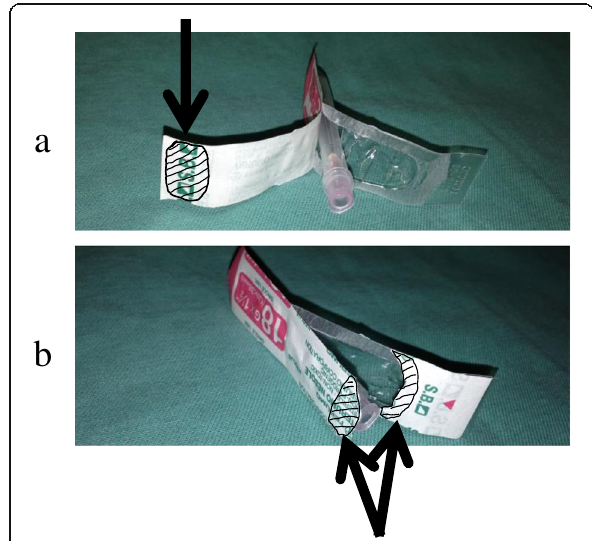
Fig. 1 Opening methods. a Peel-apart method: opening by peeling the adhered planes of the blister and mount. b Push-off top method: opening by pressing the needle hub to the mount and breaking it. The arrow indicates the part at which the bacterial suspension was applied